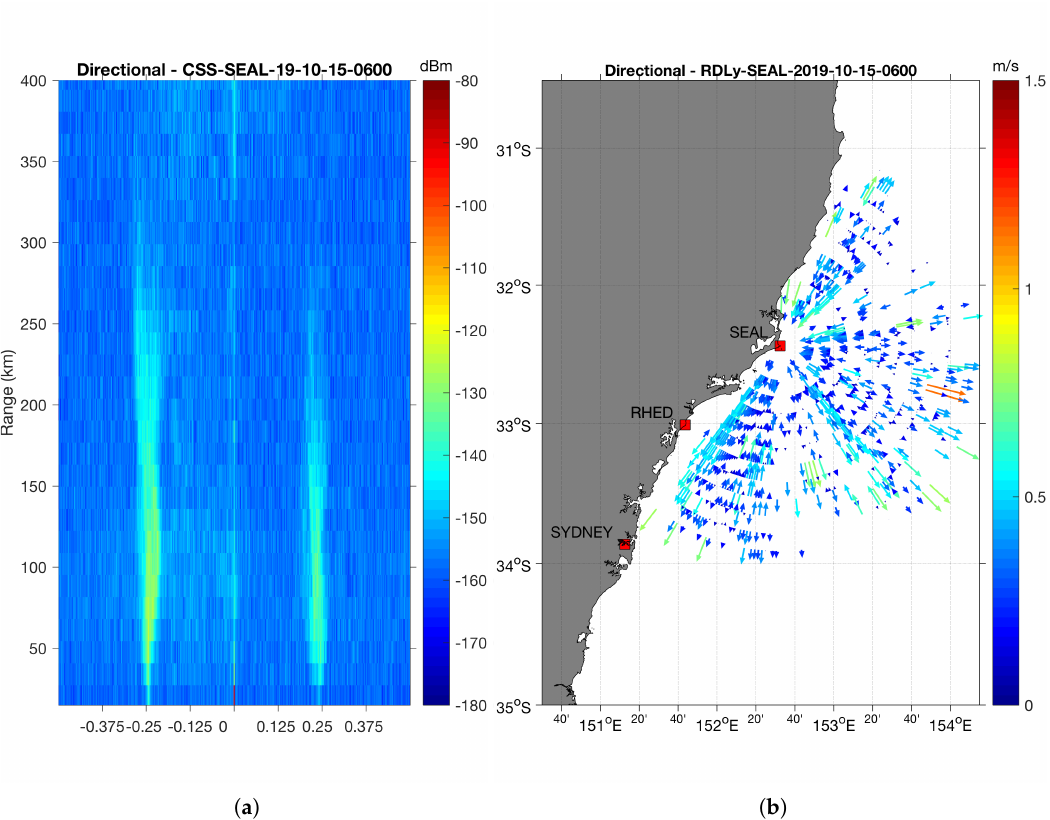
Figure 14. Range Doppler spectra collected with the directional transmit antenna ( a ) and radial velocity map ( b ) for Seal Rocks. See (Figure 12) for